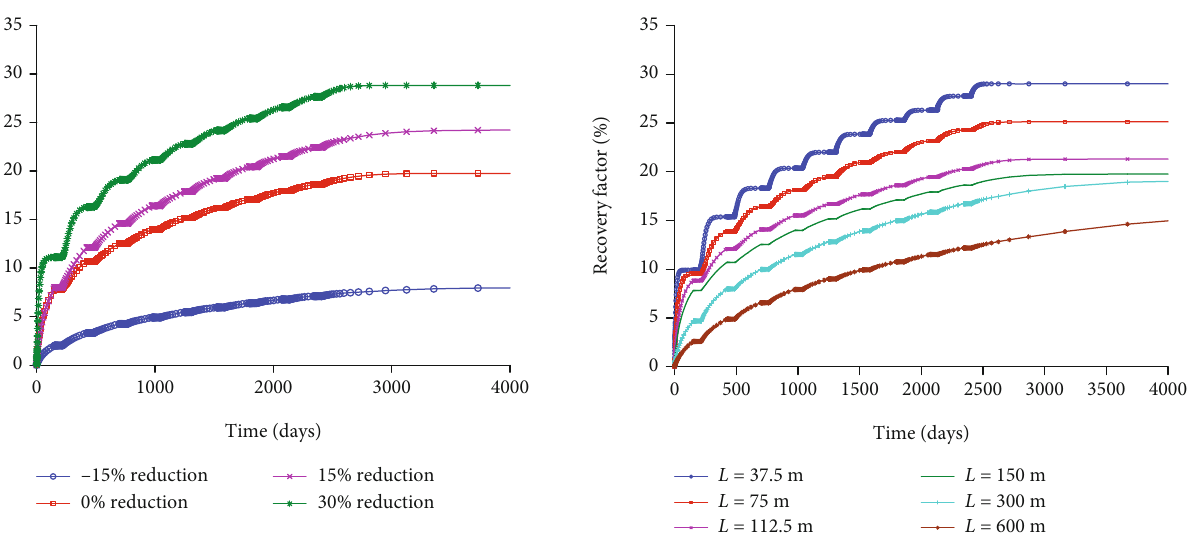
Figure 9: Production curves of reservoirs with di ff erent Sor reduction values by cyclic surfactant injection.